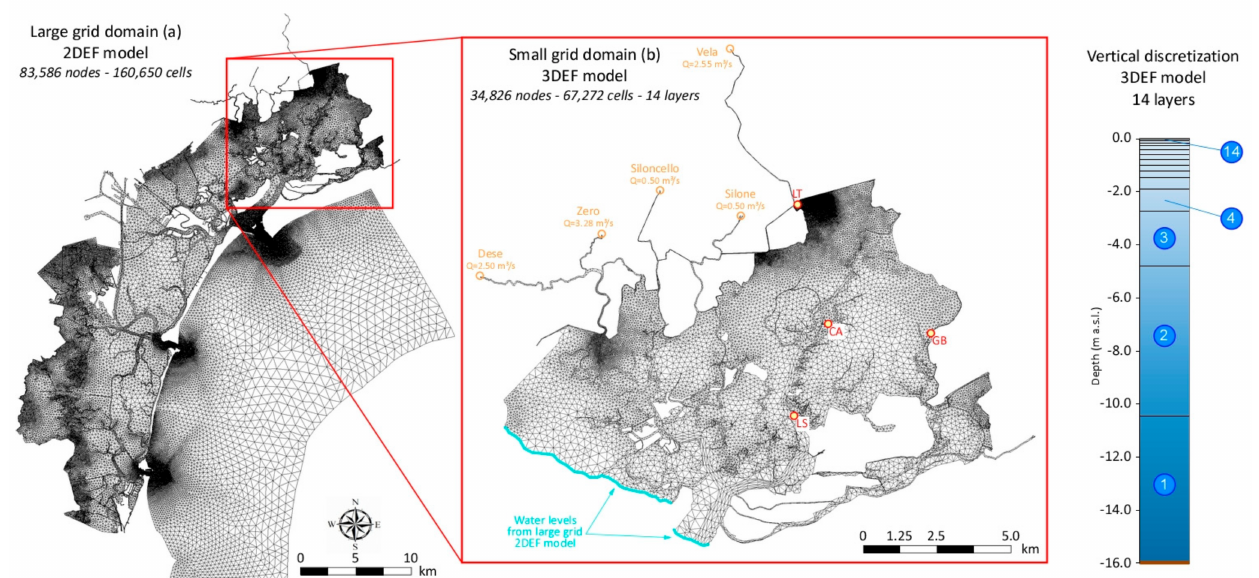
Figure 4. Unstructured triangular meshes used for model simulations; ( a ) domain of the whole Venice lagoon used with the 2DEF model (83,586 nodes and 160,650 triangular cells); ( b ) sub-domain of the northern lagoon used with the 3DEF model (34,826 nodes and 67,272 triangular cells, 14 layers). Tidal gauge locations (Le Trezze-LT, Grassab ò -GB, Canal Ancora-CA e Le Saline-LS stations) are depicted.